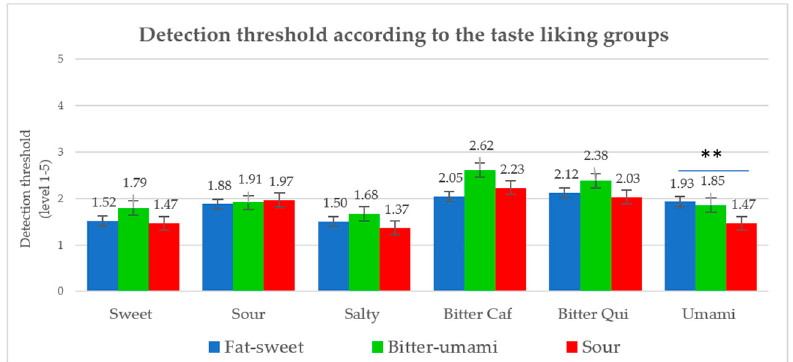
Figure 4. Mean detection threshold level for the three taste-liking groups (Caf = caffeine, Qui = quinine, ** p < 0.05 from ANOVA test).